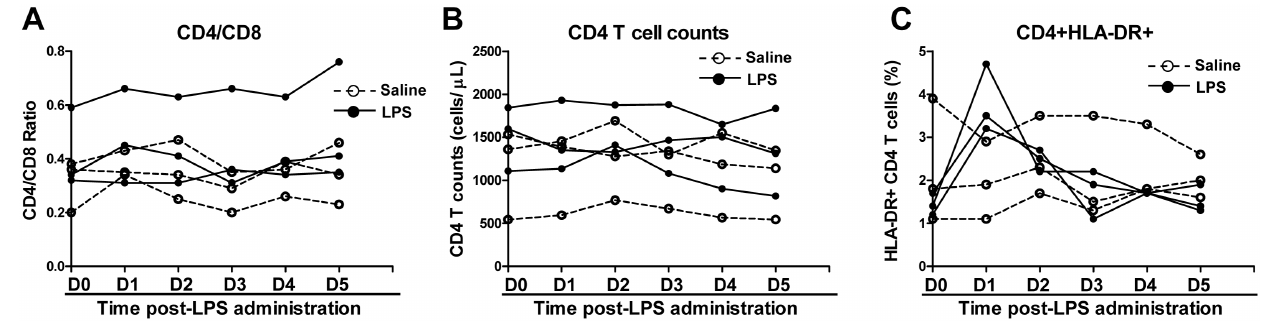
Figure 4. Effect of LPS on CD4/CD8 ratio, counts of CD4 + T cells and frequency of CD4 + HLA-DR + T cells. SIVmac239-infected animals were intravenously injected with either LPS (50 m g/kg; solid circles and lines, n=3) or saline (open circle and dashed lines, n=3) at 45 weeks postinfection. At the indicated time points after LPS administration, the CD4/CD8 ratios (A), total CD4 + T cell counts (B), and CD4 + HLA-DR + T cell percentage in PBMCs (C) were determined by flow cytometry.